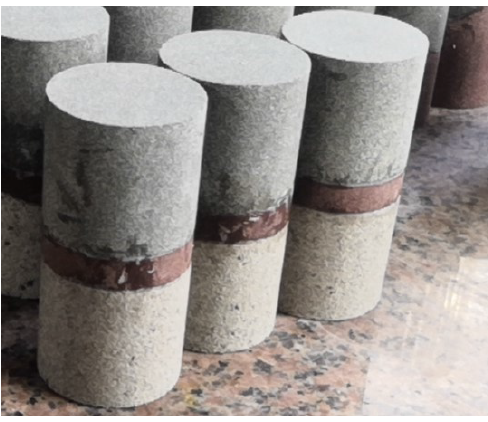
Fig. 2 Layered composite rock